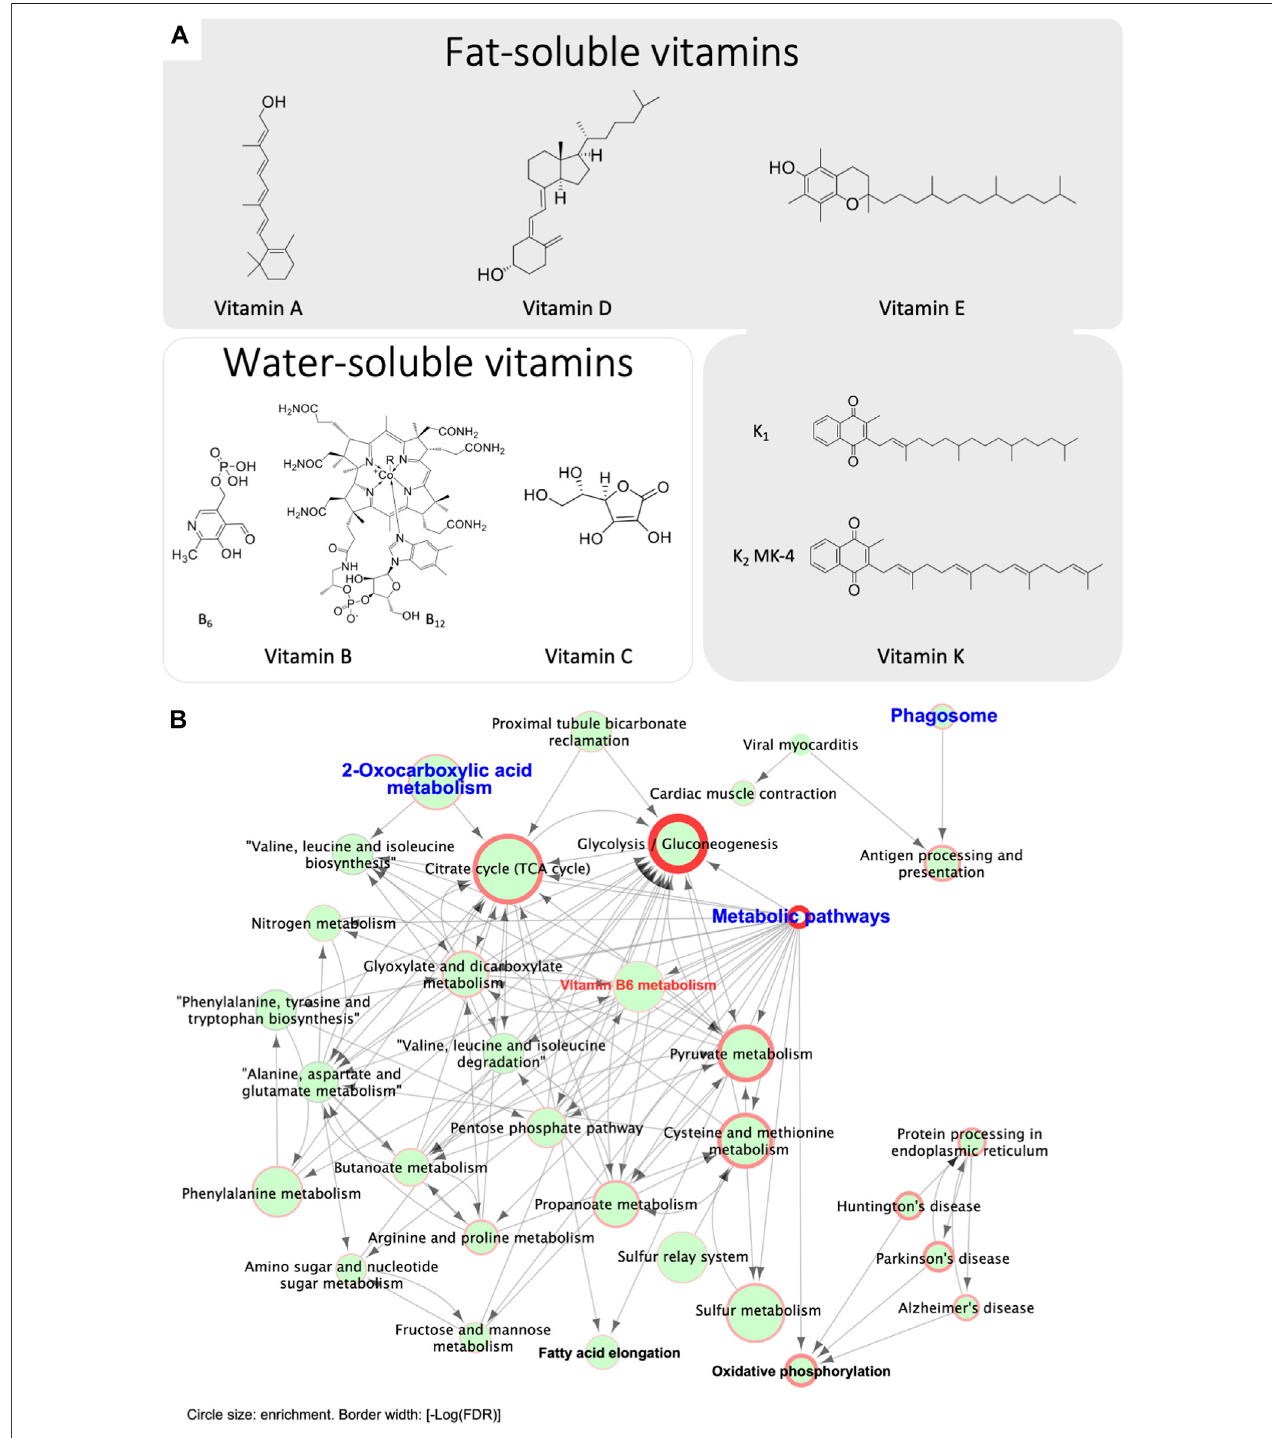
FIGURE 6 | Bioinformatic analysis reveals potential involvement of vitamin B6 pathways in regulating epididymal Ca 2+ homeostasis and Ca 2+ -dependent MGP- aggregation. (A) Chemical structures of the key members of various fat-soluble and water-soluble vitamins. (B) Bioinformatic analysis reveals a potential involvement of vitamin B6 in epididymal Ca 2+ homeostasis. Presented data were originally published in iScience (Ma et al., 2019) and reanalyzed. Brie fl y, proteomic analysis the in-gel digested MGP-positive 32-kDa band was performed with LC-MS/MS analysis ( n = 3 rats). The MGP-positive 32-kDa band in whole epididymis protein lysates underwent proteomic analysis followed by GO and KEGG-based bioinformatic analysis and identi fi ed 301 genes present in all 3 lysates. 2-oxocarboxylic acid metabolism is one of the primary enriched gene clusters, consistent with MGP carboxylation. Other key enriched clusters include phagosome and its downstream